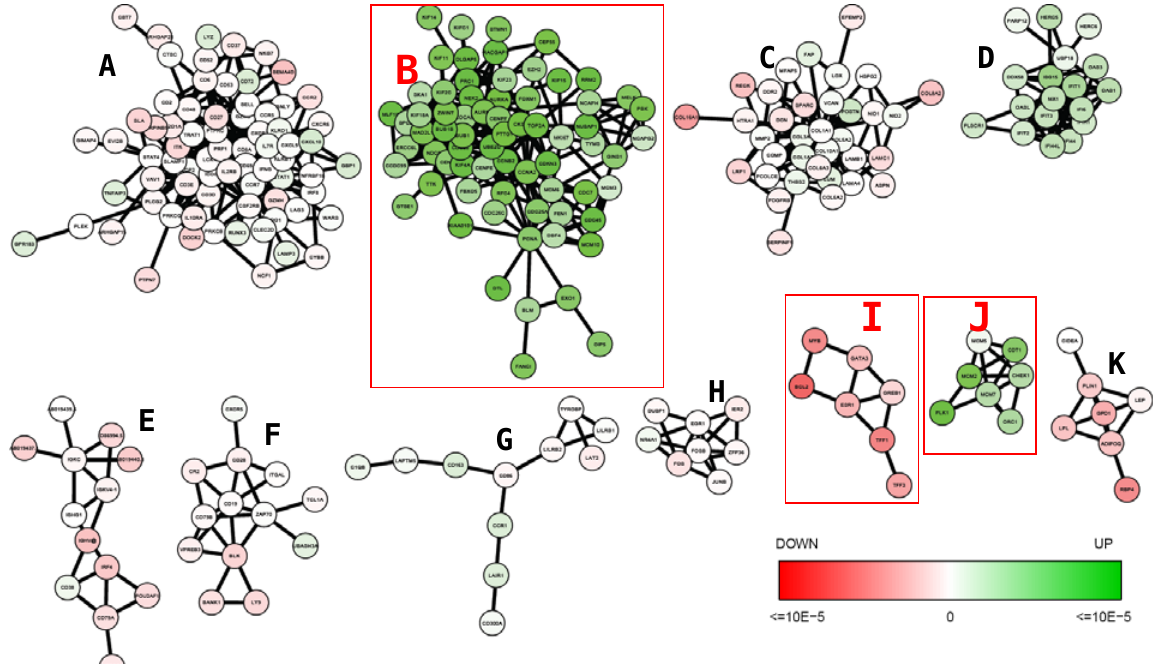
Figure 1: Disjoint sub networks of varying sizes were obtained from the Desmedt study. An overview of the largest sub networks is displayed here. Genes are colored according to the p- value of the Welch-t test on the expression between POOR and GOOD outcome subjects (green is higher expressed in POOR). A red bounding box around a sub network indicates a significant sub network score obtained with the global test on the gene set indicated by the sub